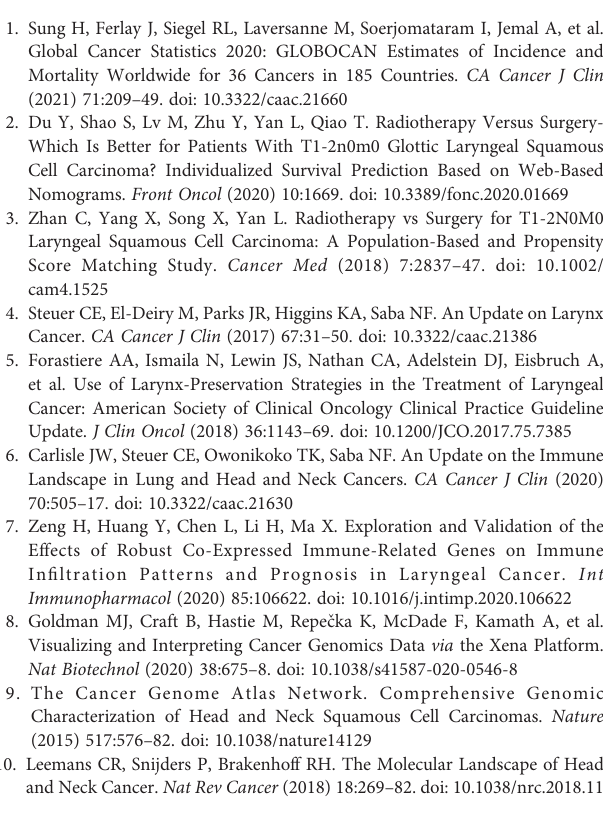
Supplementary Figure 3 | Venn Plots of genes, miRNAs, and lncRNAs differentially expressed both in the TCGA and GEO cohorts. (A) genes. (B) miRNAs. (C) lncRNAs.